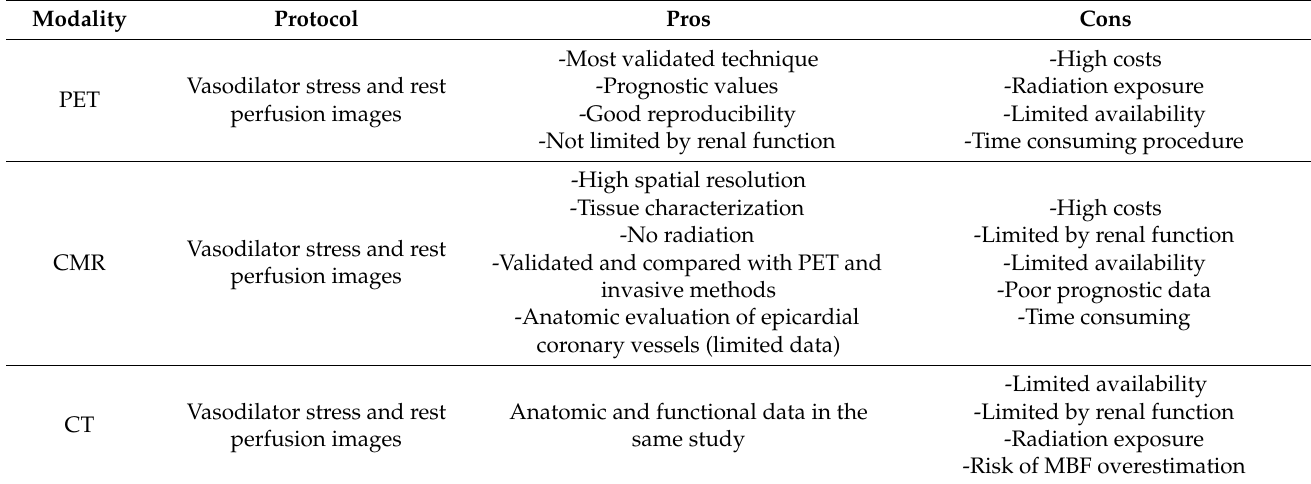
Table 3. Pros and cons of the three advanced imaging